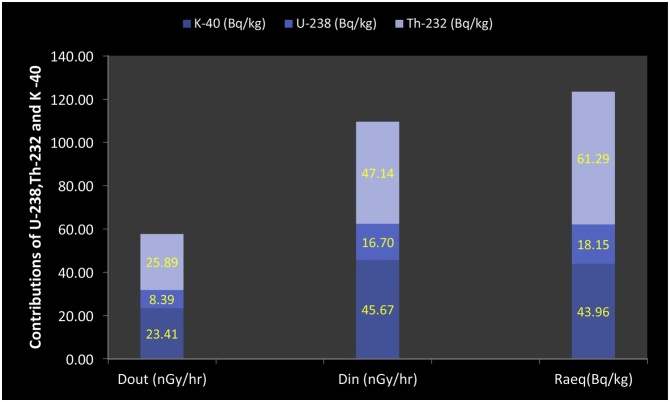
Contributions of 40K, 238U and 232Th to Dout, Din and Raeq.